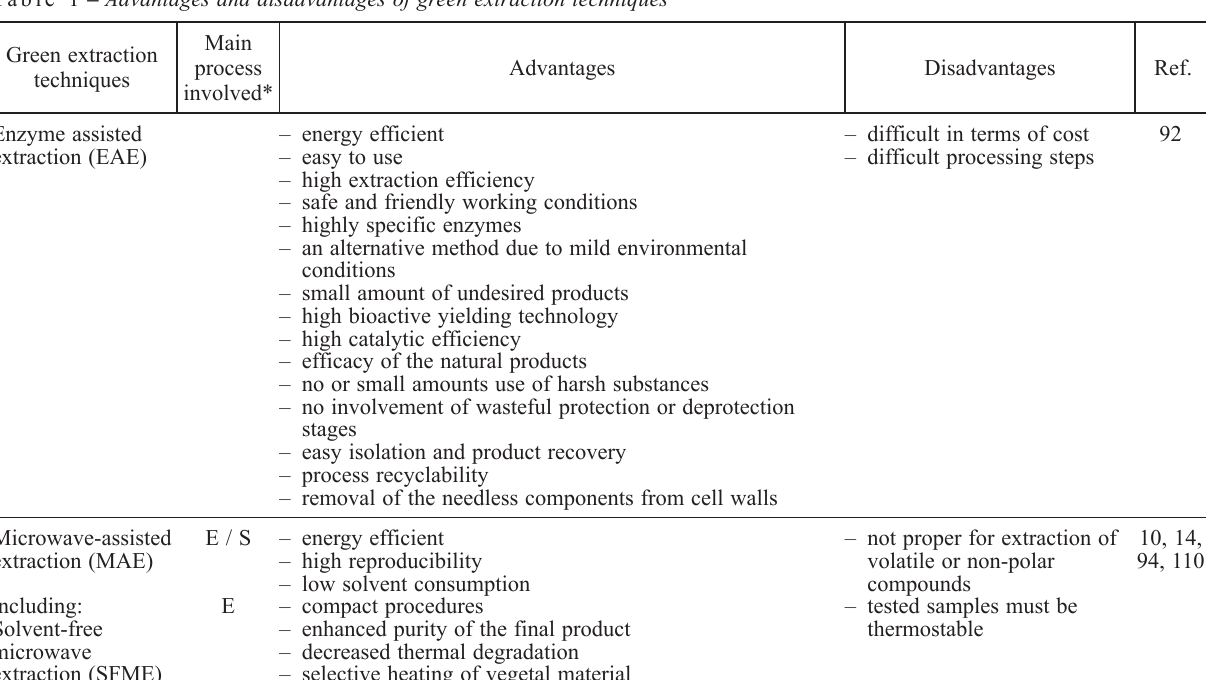
Table 1 – Advantages and disadvantages of green extraction techniques Green extraction